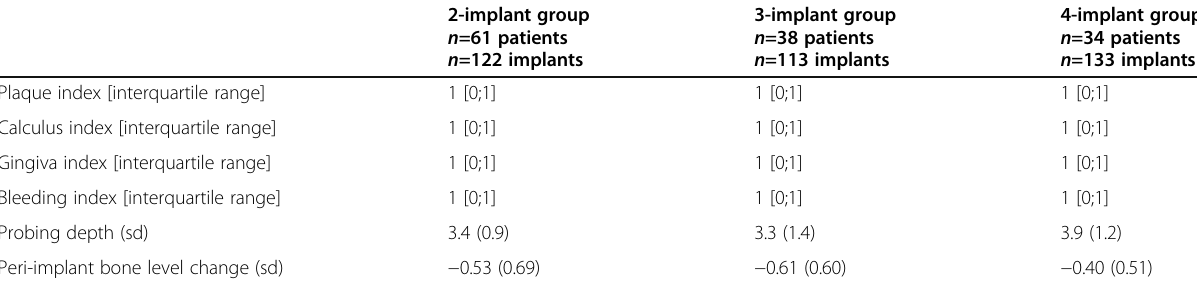
Table 2 Median values with interquartile range of plaque index (score 0 – 3), calculus index (score 0 – 1), gingiva index (score 0 – 3), and bleeding index (score 0 – 3), and mean values with standard deviation of probing depth (in mm) and peri-implant bone level change (in mm) for each group